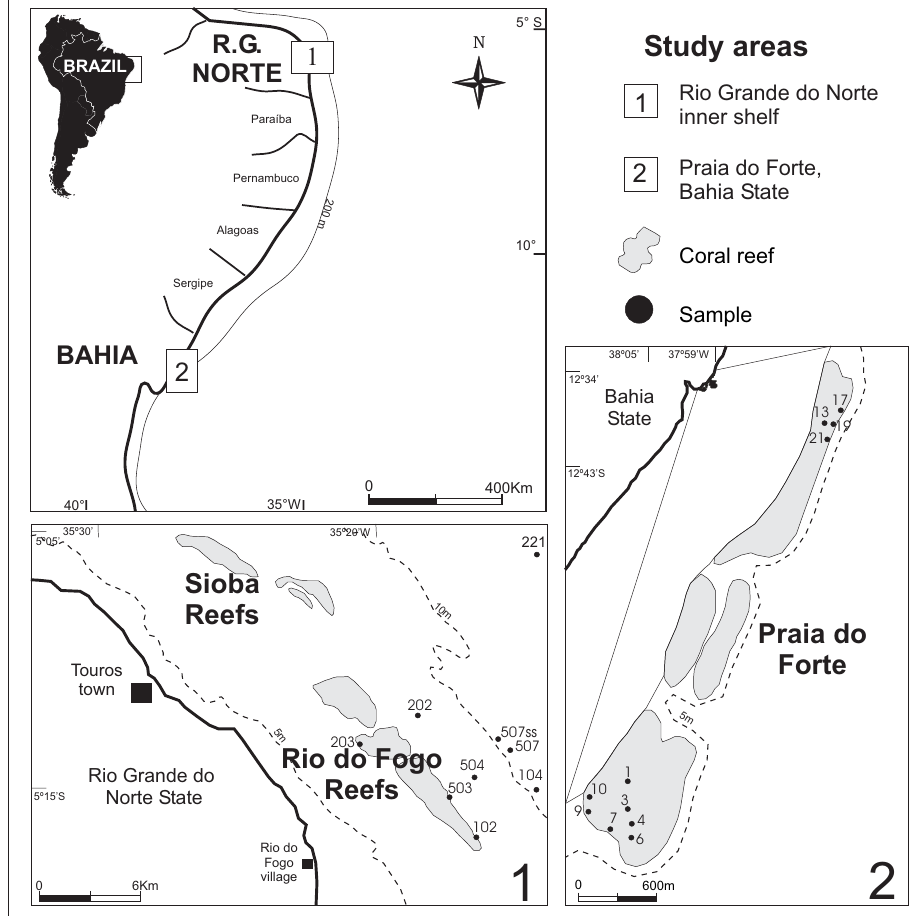
Fig. 1 – Map of the studied reefs with location of the samples containing Homotrema rubrum